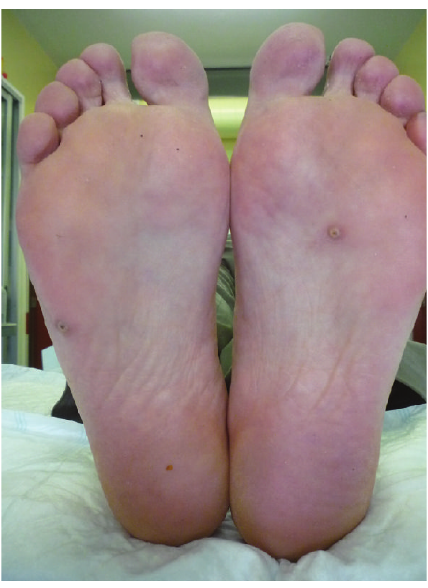
Figure 1: Papular lesions with a small brown-black central core were distributed on the soles and lateral aspect of the toes.